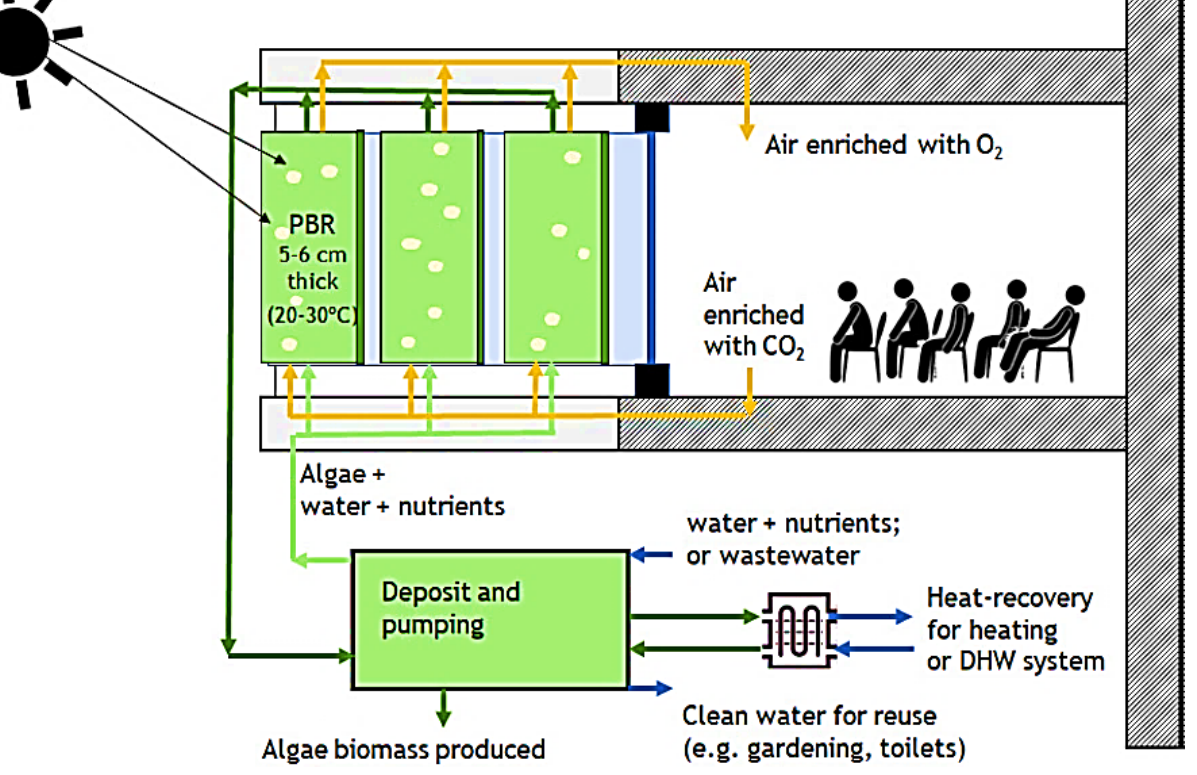
Figure 4. Microalgae cultivation system integrated into a building for indoor air treatment [144]. PBR = photobioreactor. Reproduced with permission from MDPI.